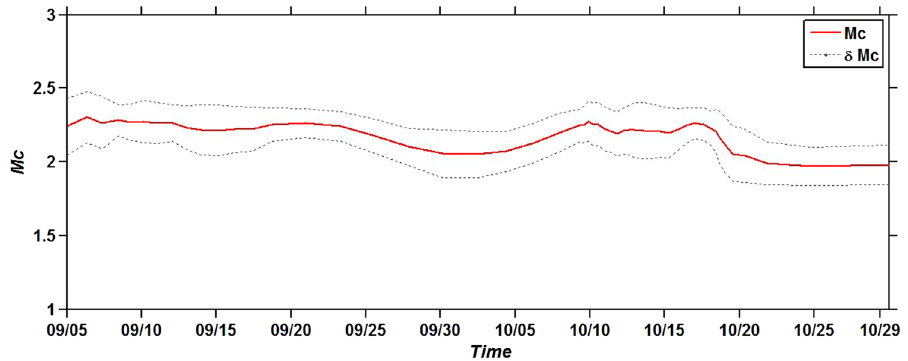
Figure 10. M c as function of time for a sample window of 50 events and 10% of overlapping. The figure was generated by using the ZMAP software.